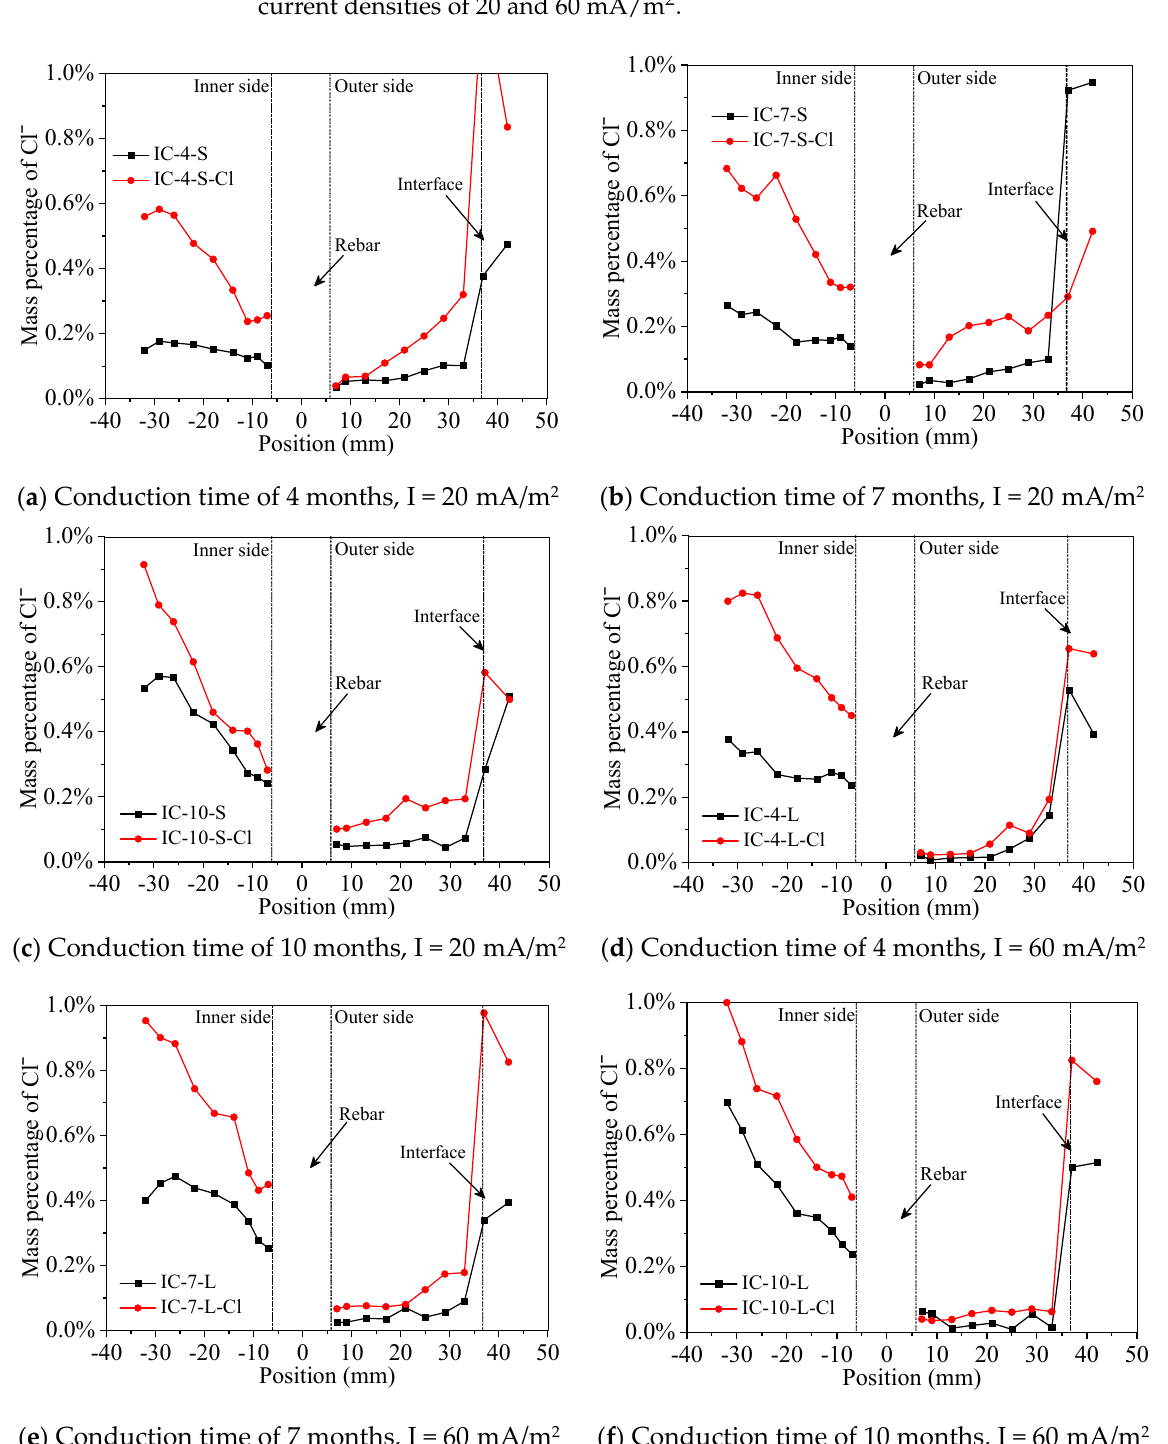
Figure 13. Influence of salt addition or not on distribution of Cl − content in both sides of rebars.